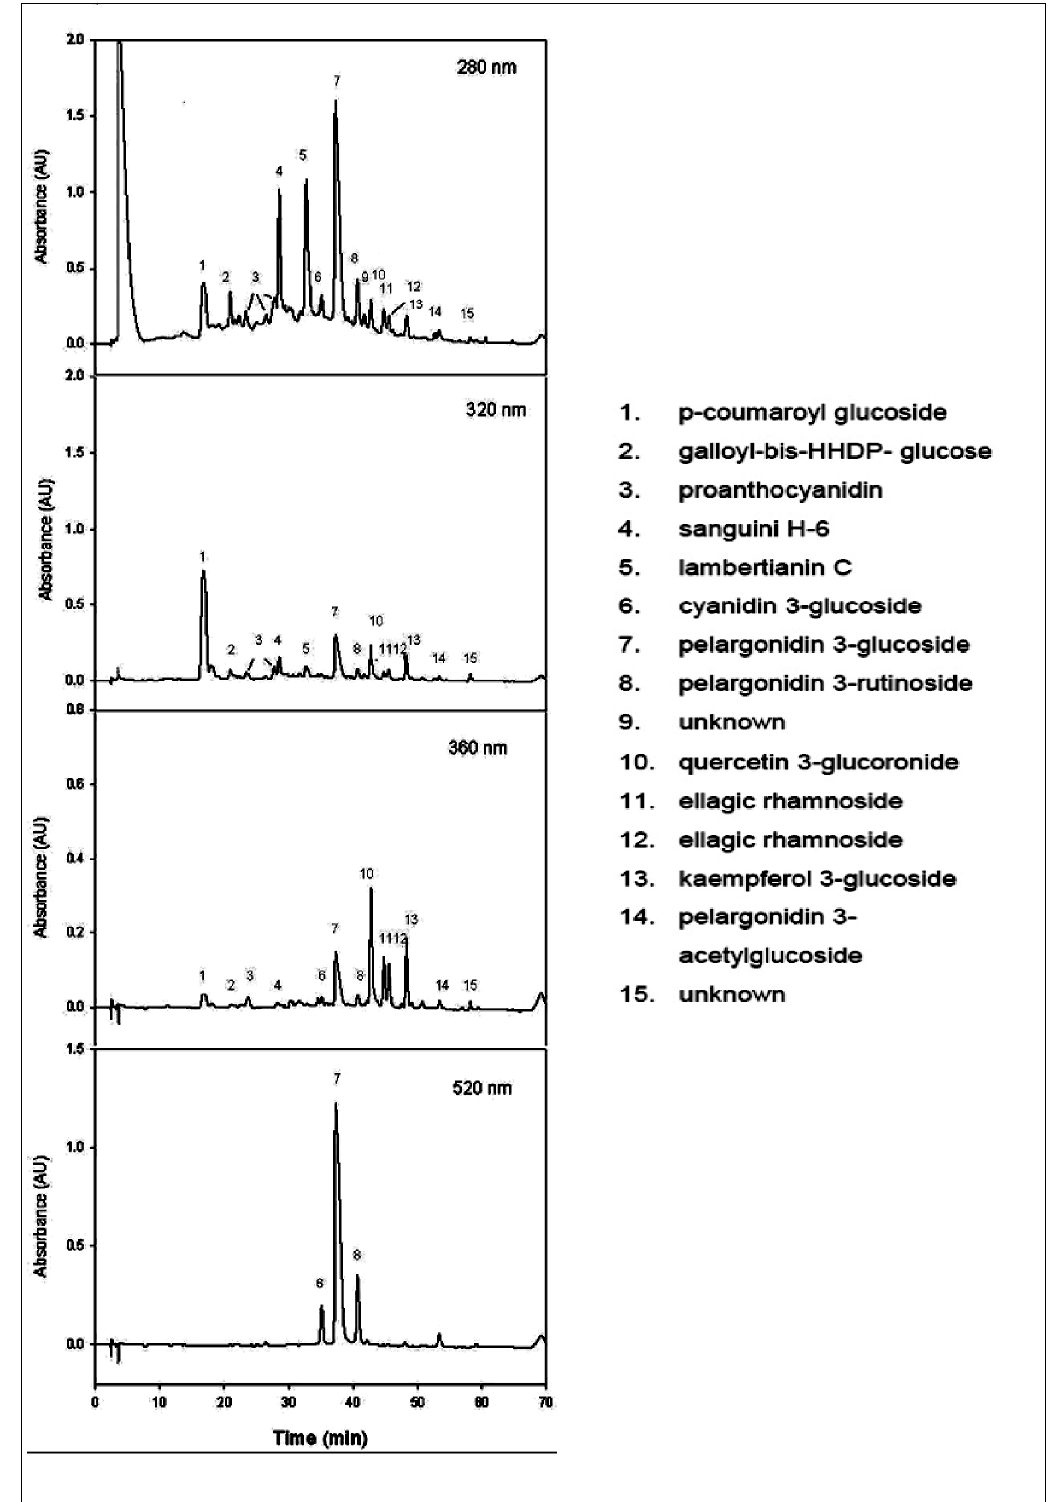
Fig. 1: Chromatographic patterns of strawberry phenolic compounds obtained at 280, 320, 360 and 520 nm. Peak assignment is provided on the right side.